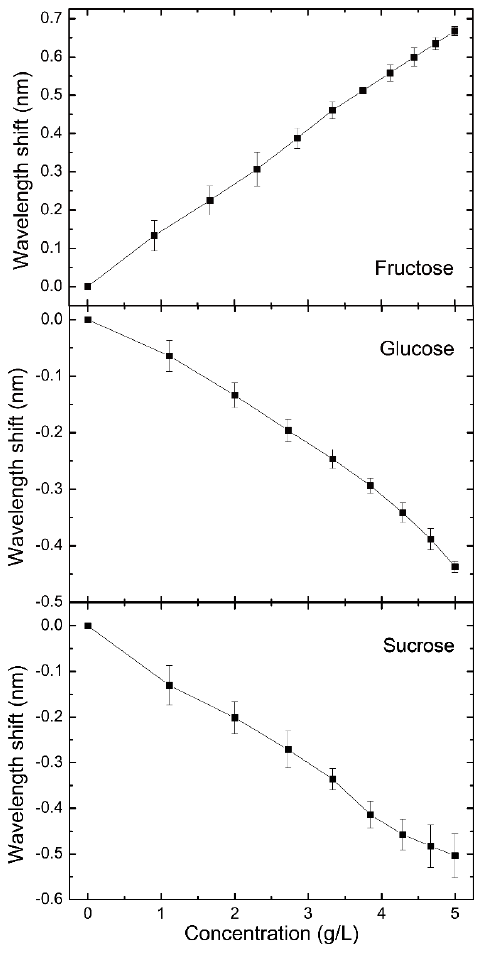
Figure 5. The concentration response curves of fructose, glucose and sucrose.